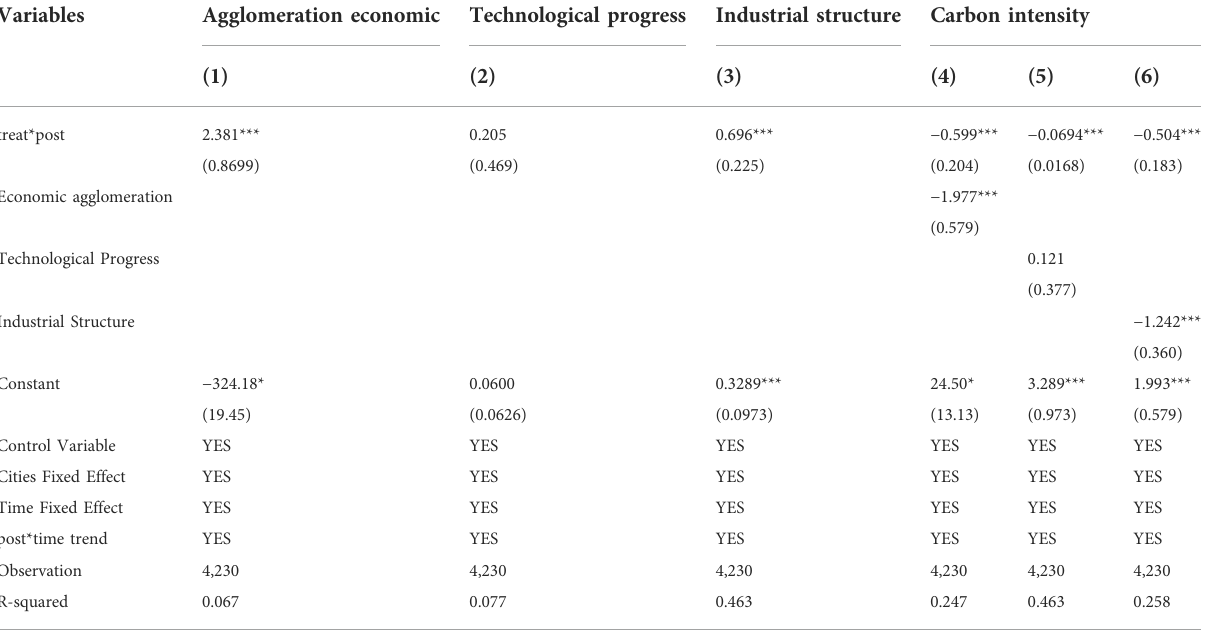
TABLE 10 Test of action